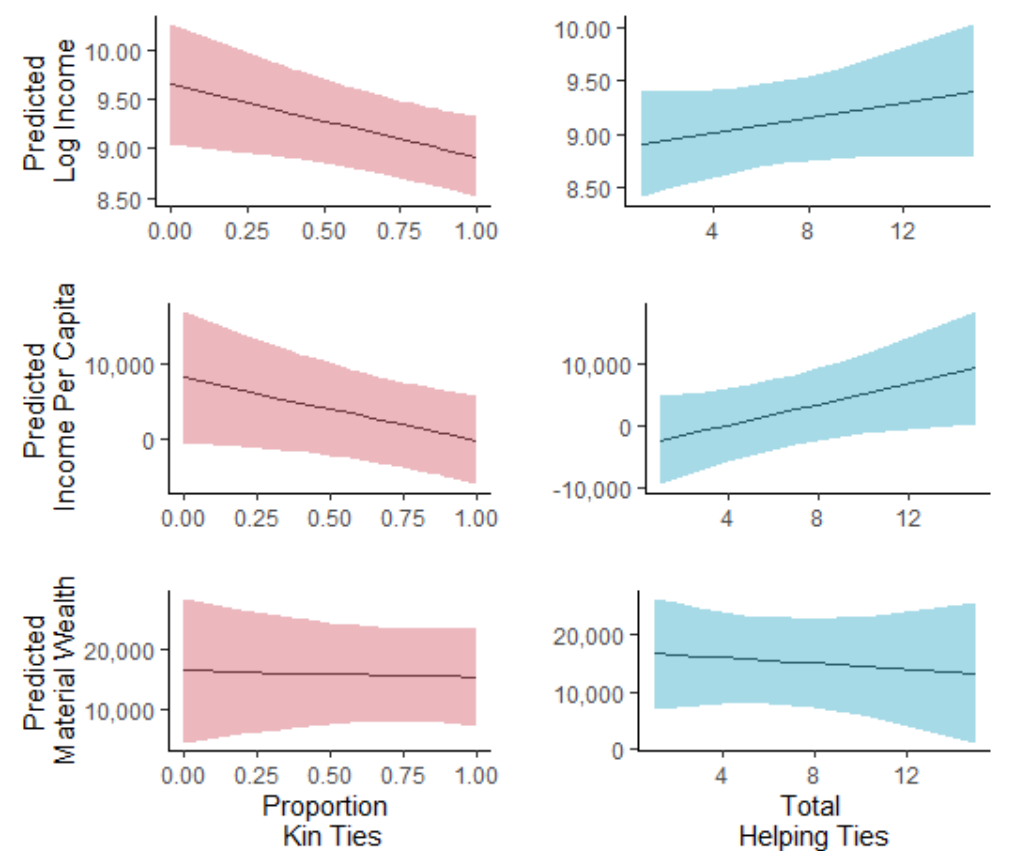
Figure 5. Marginal effects plots of Proportion of Kin Ties ( Left ) and Total Helping Ties ( Right ) on economic outcome variables. Marginal effects are calculated by holding constant all other variables in the model. Economic Diversity = 3.38, Age of Male HH = 44.15, Subsistence Agriculture = 1, Total Helping Ties = 5.41, and Proportion of Kin Help = 0.81.